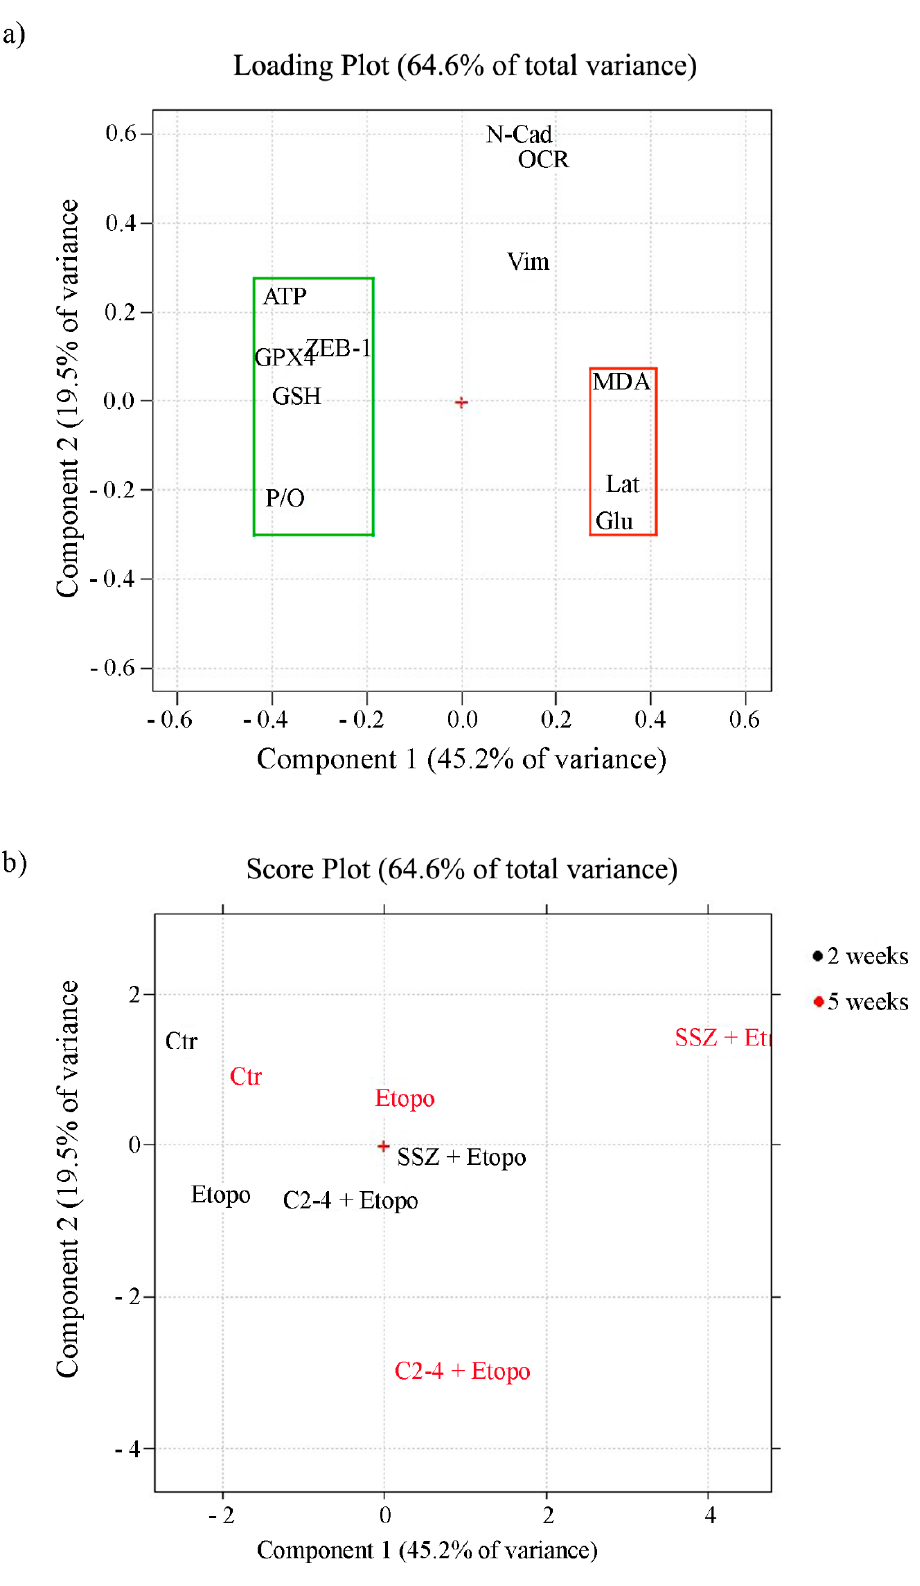
Figure 12. Loading ( a ) and score ( b ) plots. ( a ) The variables which sustain chemoresistance (green rectangle: ATP, GSH, P/O, ZEB-1, GPX4) have negative loadings on PC1 values, while the variables that are able to induce chemosensitivity (red rectangle: MDA pro- duction, lactate release and glucose consumption) have positive loadings on PC1; variables N-CAD, OCR and Vim have instead high loadings on PC2 ( b ) In the score plot, the black-colored samples were treated for two weeks, while the red-colored ones were treated for five weeks.